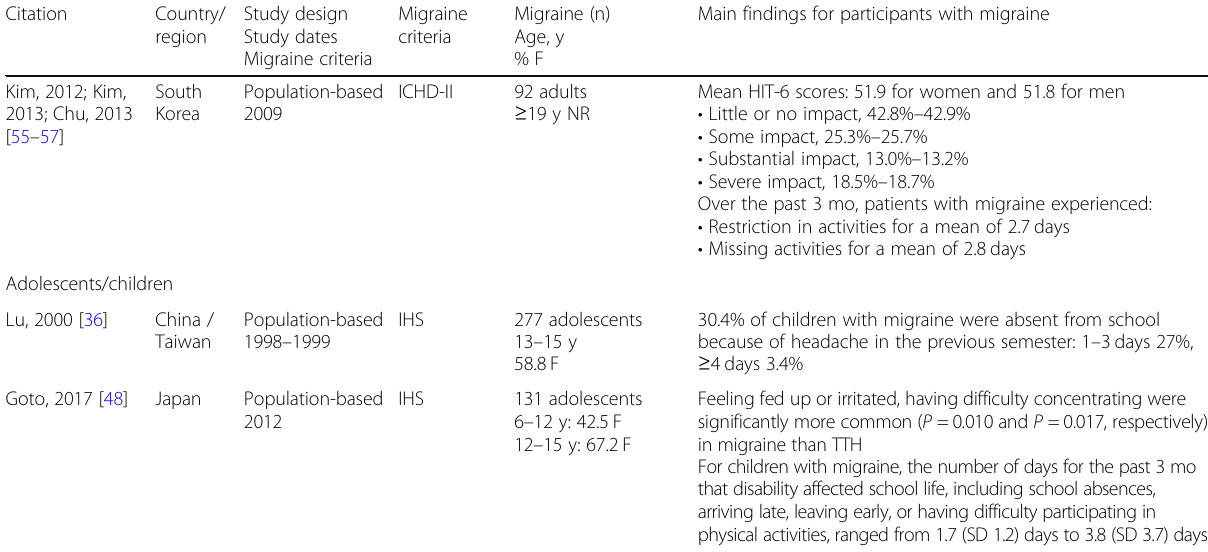
Table 1 Studies reporting humanistic burden of migraine